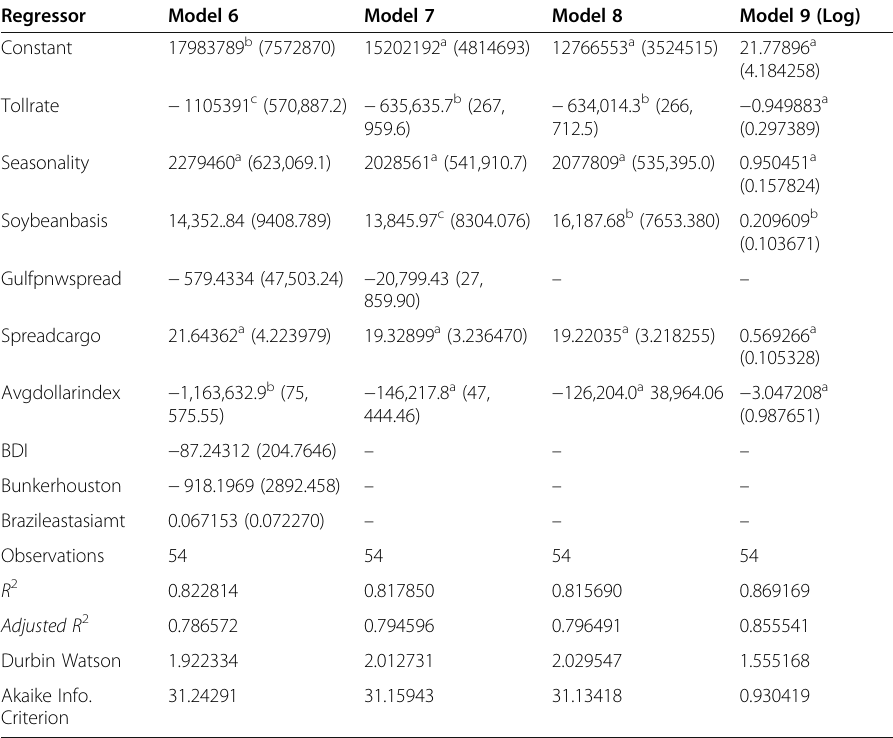
Table 5 OLS estimation of soybean traffic using quarterly transformed data Regressor Model